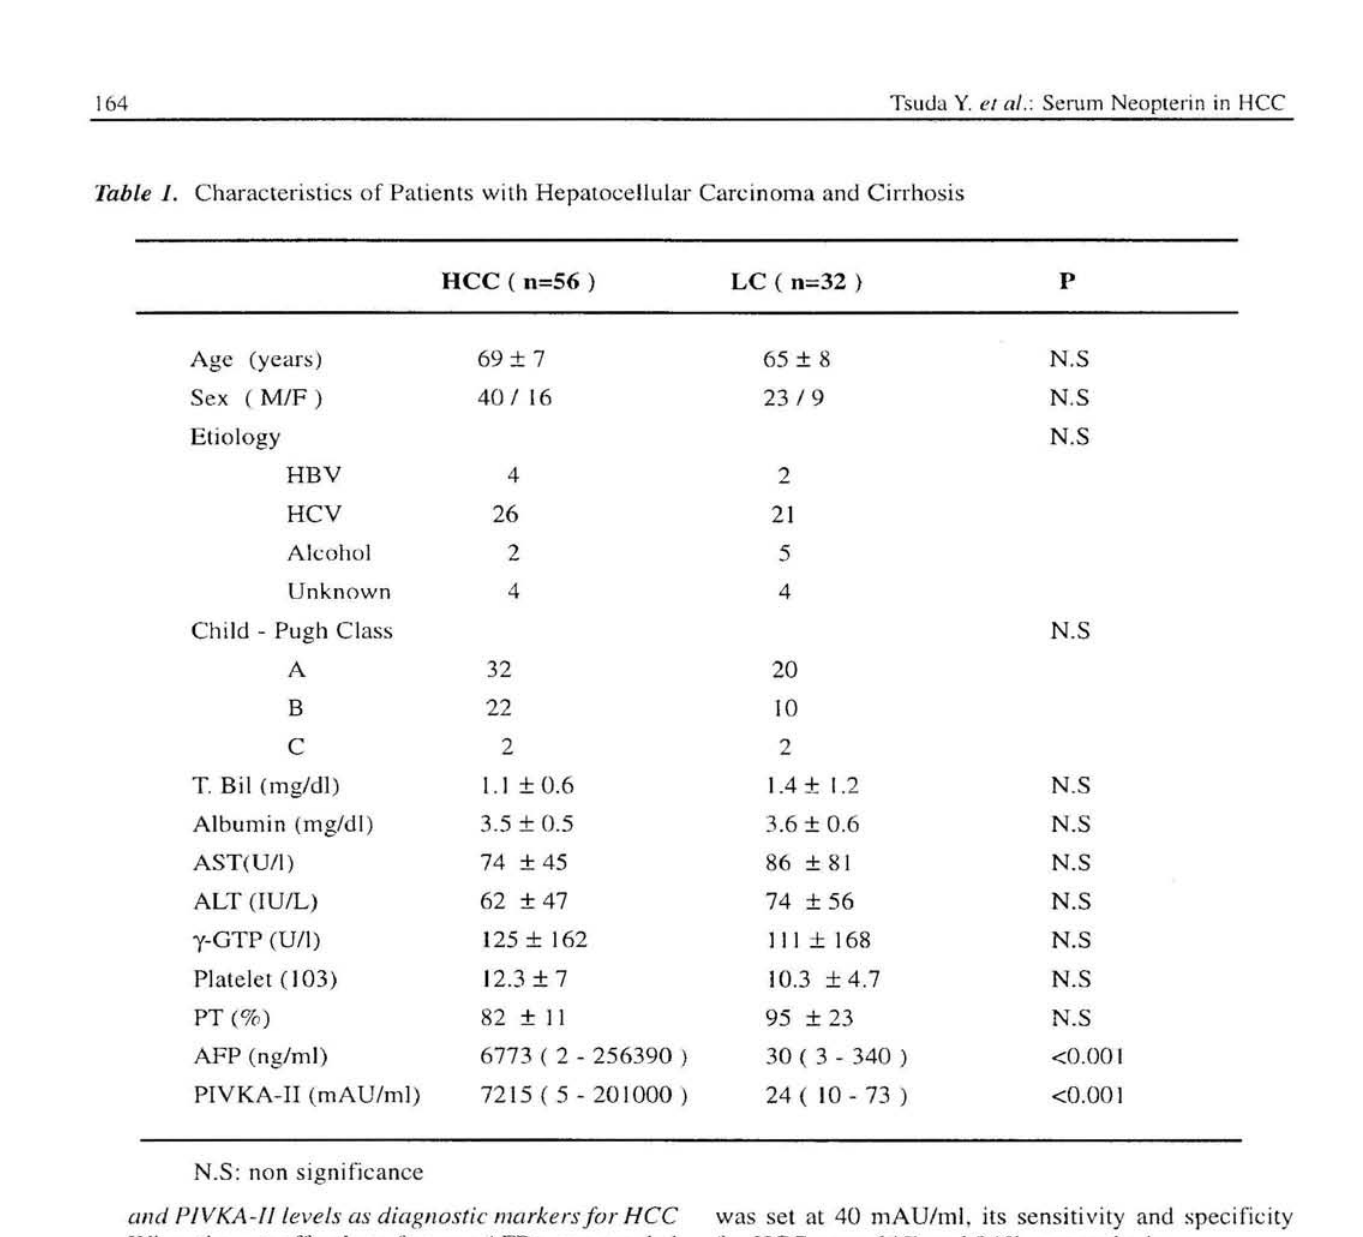
Table 1. Characteristics of Patients with Hepatoceüular Carcinoma and